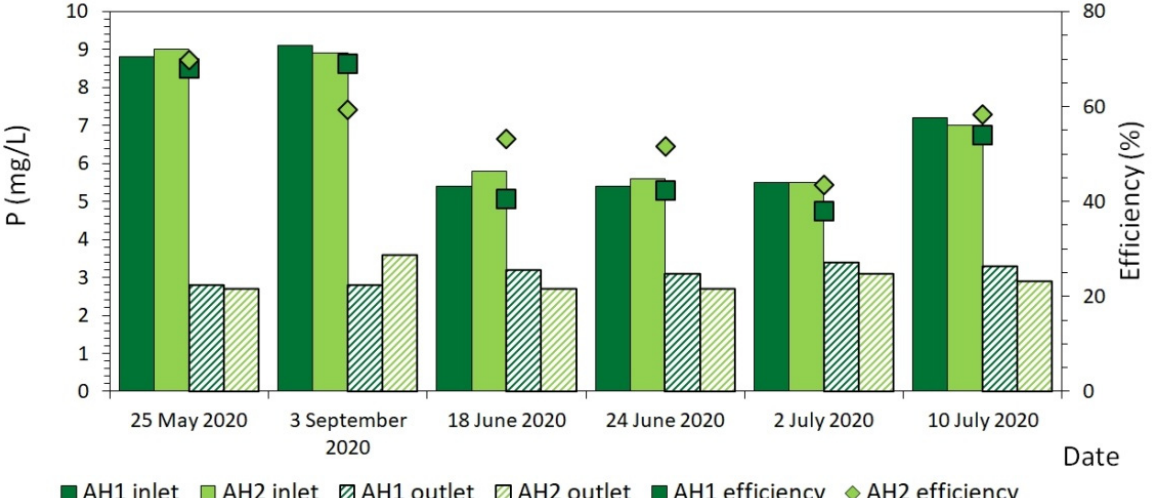
Figure 7. Inlet and outlet P tot and removal efficiencies at stage II. Total phosphorus removal efficiencies of both types of material (angel hair and scraps) were very similar at both stages I and II. The obtained efficiencies are rather typ- ical for single-stage trickling filters.